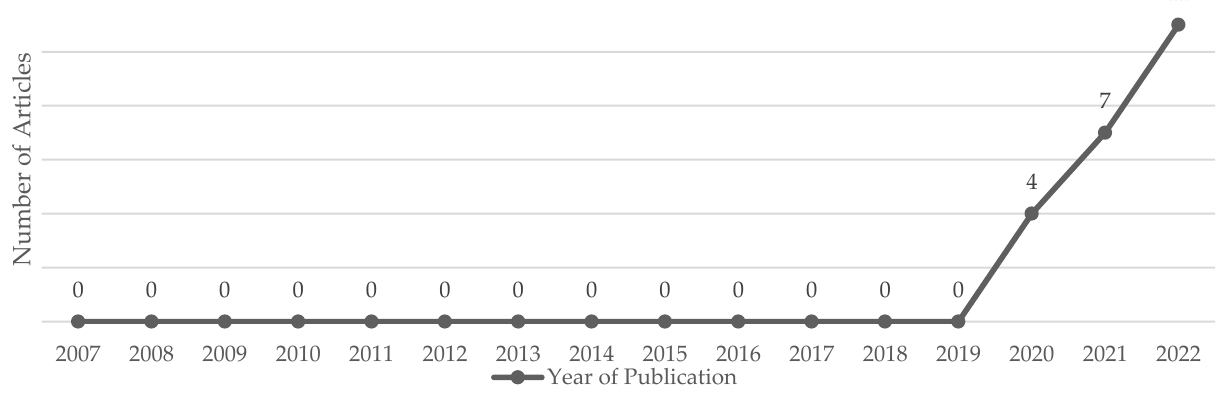
Figure 2. Publication years of the reviewed articles.